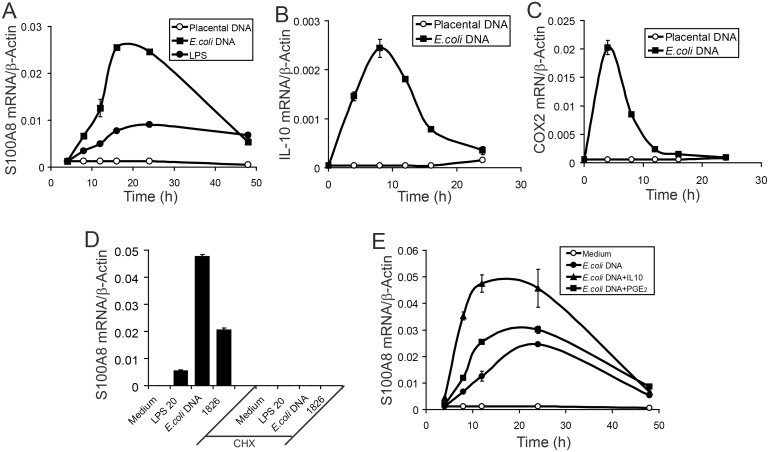
Induction of S100A8 in macrophages by E. coli DNA is late and requires newly synthesis proteins.(A–C) RAW264.7 macrophages were treated with 3 µg/ml placental DNA, 3 µg/ml E. coli DNA, or 20 ng/ml LPS for the indicated times. S100A8 (A), IL-10 (B), or COX-2 (C) mRNAs quantitated by qRT-PCR. (D) Effects of CHX (2 µg/ml) on LPS (20 ng/ml), E. coli DNA (3 µg/ml), or CpG-containing ODN (1826, 3 µM)-induced S100A8 mRNA expression. (E) Cells incubated with E. coli DNA (3 µg/ml) ± IL-10 (2 ng/ml) or ± PGE2 (10 µM), harvested at the indicated time points and mRNAs quantitated. Data represent means ± SD of duplicates and representative of 3 experiments.